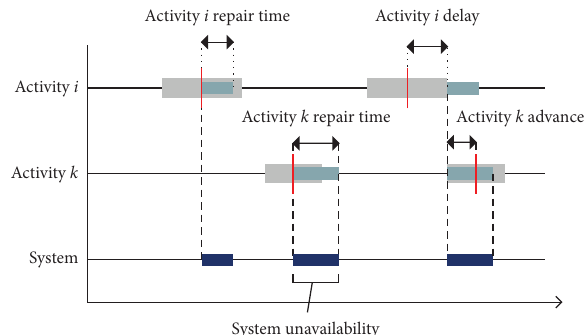
Figure 2: Scheme of grouping two activities of diferent compo- nents confgured in